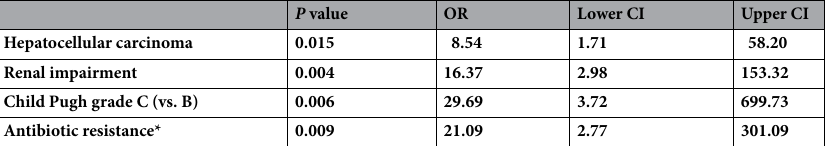
Table 4. Factors associated with initial treatment failure (Multivariate analysis). Antibiotic resistance* includes resistance to one of cefotaxime, ciprofloxacin, vancomycin, and ESBL( +). Significant values are in